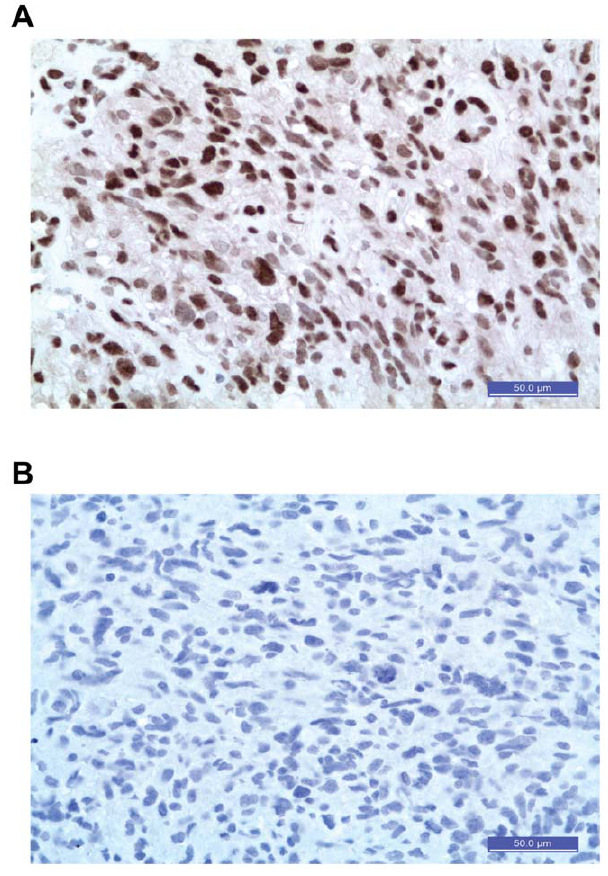
Figure 3. Tumors with the non defined telomere maintenance mechanism with both p16 INK4a alleles produce p16 INK4a . All tumors used to confirm the presence or losses of p16 INK4A gene dosage by fluorescent in situ hybridization [21] were analyzed by immunohis- tochemistry for the p16 INK4A protein. A. Photomicrographs to illustrate tumor cells positive for p16 INK4A in a GBM typed with both p16 INK4A alleles by FISH. B. Photomicrographs to illustrate tumor cells negative for p16 INK4A in a GBM typed with loss of both p 16 INK4A alleles by FISH. DAB positive cells were detected by light microscopy at 400 6 magnification, scale bars are included.